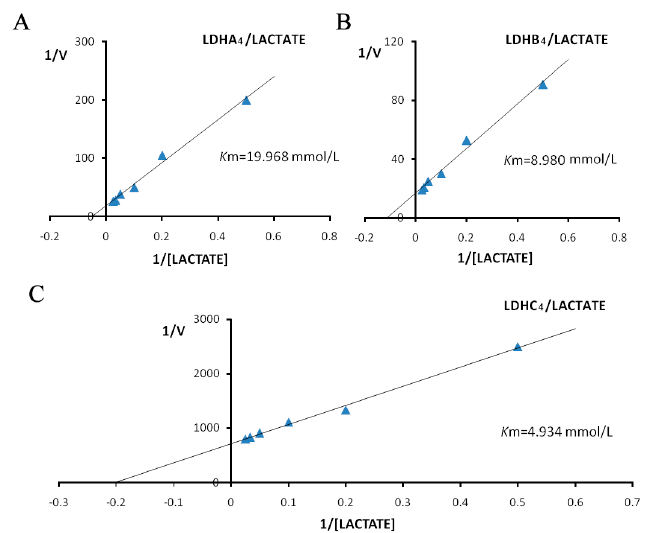
Figure 6. Double reciprocal plots by lactate as substrate of plateau pika LDH isozymes. Double reciprocal plots of ( A ) LDH-A 4 ; ( B ) LDH-B 4 ; and ( C ) LDH-C 4 , respectively. Reciprocal velocity ( V ) was calculated with the reciprocal ∆ 340 nm/min, plots were preformed by calculating the reciprocal reaction velocity vs. reciprocal pyruvate concentration at a constant concentration of NAD + . The concentrations of lactate used were 2, 5, 10, 20, 30 and 40 mmol/L. NAD + concentration was maintained 4.934 mmol/L, respectively.